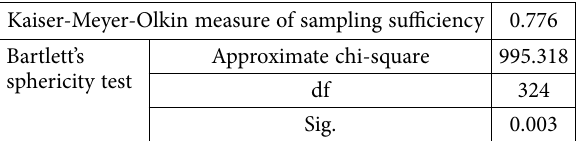
Table 2. KMO and Bartlett’s tests